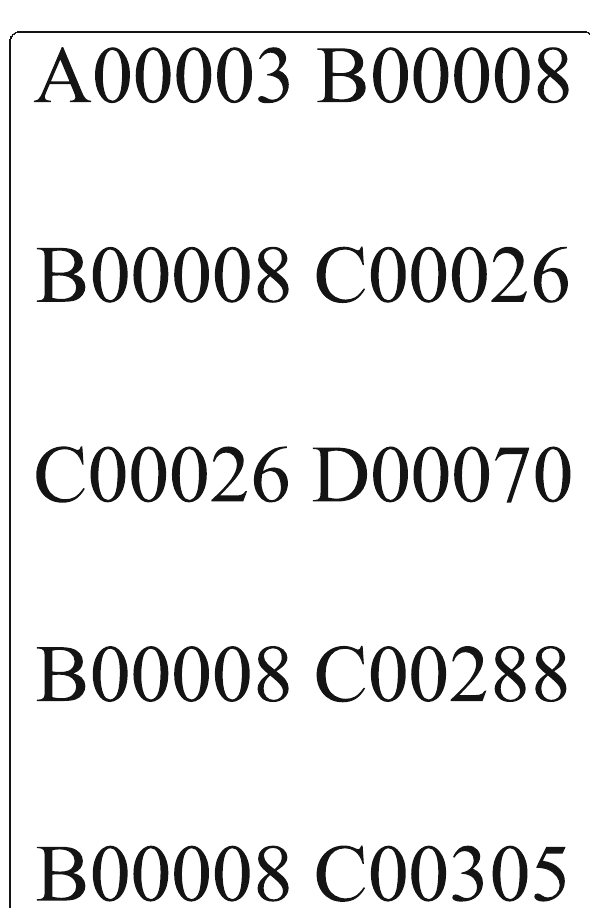
Fig. 5 Session augmentation with identical